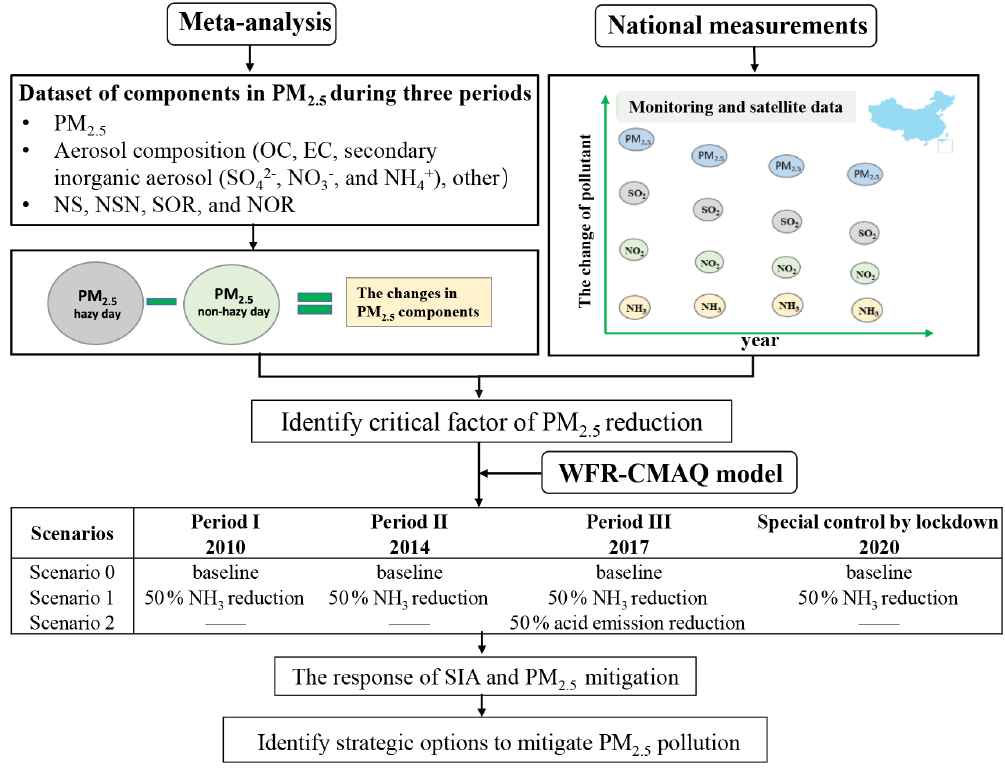
Figure 1. Integrated assessment framework for Chinese PM 2 . 5 mitigation strategic options. OC is organic carbon, EC is elemental carbon, NO − is nitrate, SO 2 − is sulfate, and NH + is ammonium. NS is the slope of the regression equation between [NH + 3 4 4 + NO − the slope of the regression equation between [NH + ] and [SO 2 − ], SOR is sulfur oxidation ratio, and NOR is nitrogen oxidation 4 4 3